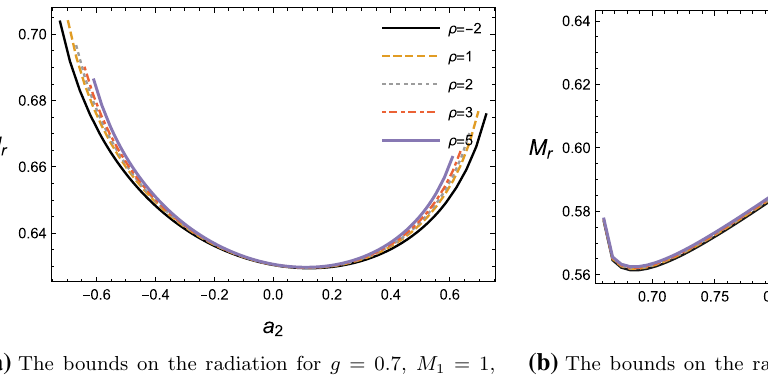
( a ) The bounds for ρ at the different M 2 under g = 0 . 5, M 1 = 1, a 1 = 0 . 35, and a 2 = 0 . 5. Fig. 11 The upper bound on the gravitational radiation with respect to ρ